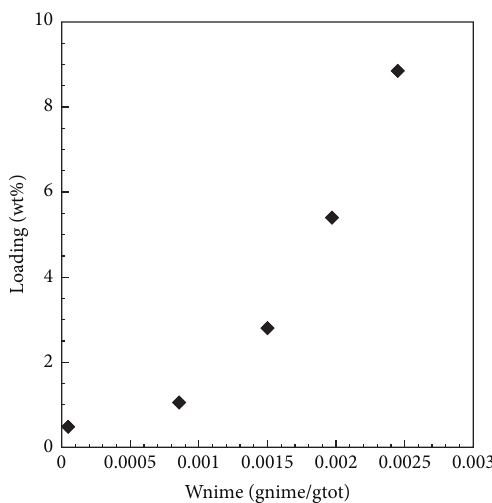
Figure 2: Adsorption isotherm for nimesulide on silica aerogel at 40 ∘ C/10MPa.